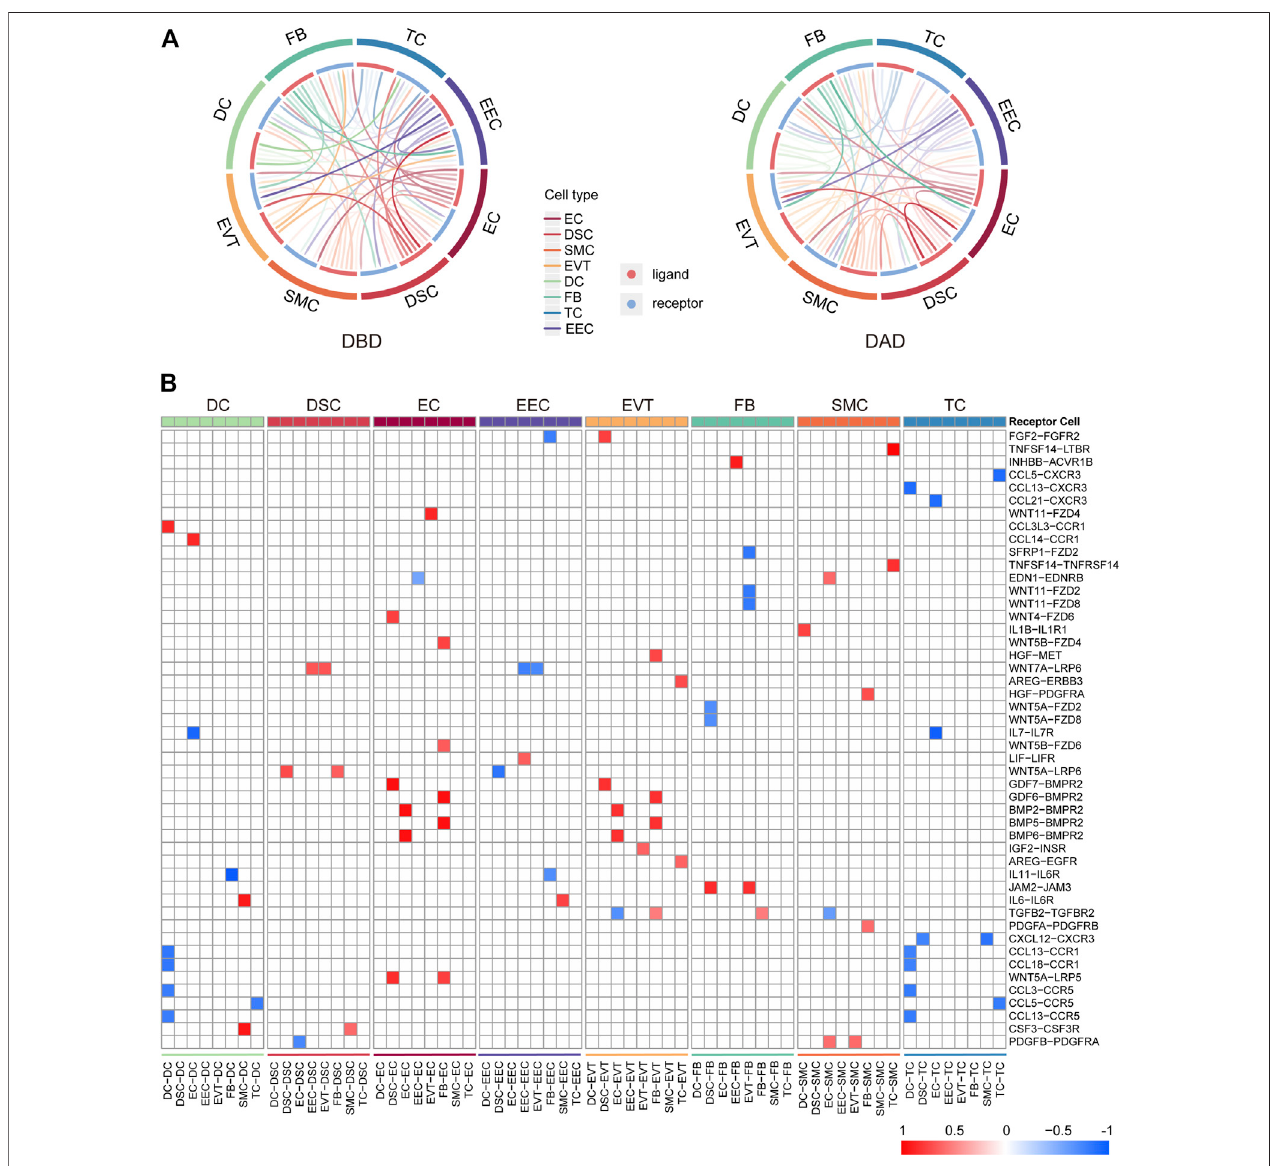
FIGURE 1 | General picture of intercellular communication in peripartum decidua. (A) Circos plot of intercellular communication among different cell types in DBD and DAD. (B) Heatmap of differential intercellular signals between DBD and DAD; red represents signi fi cantly increased intercellular communication in DAD; blue represents signi fi cantly decreased intercellular communication in